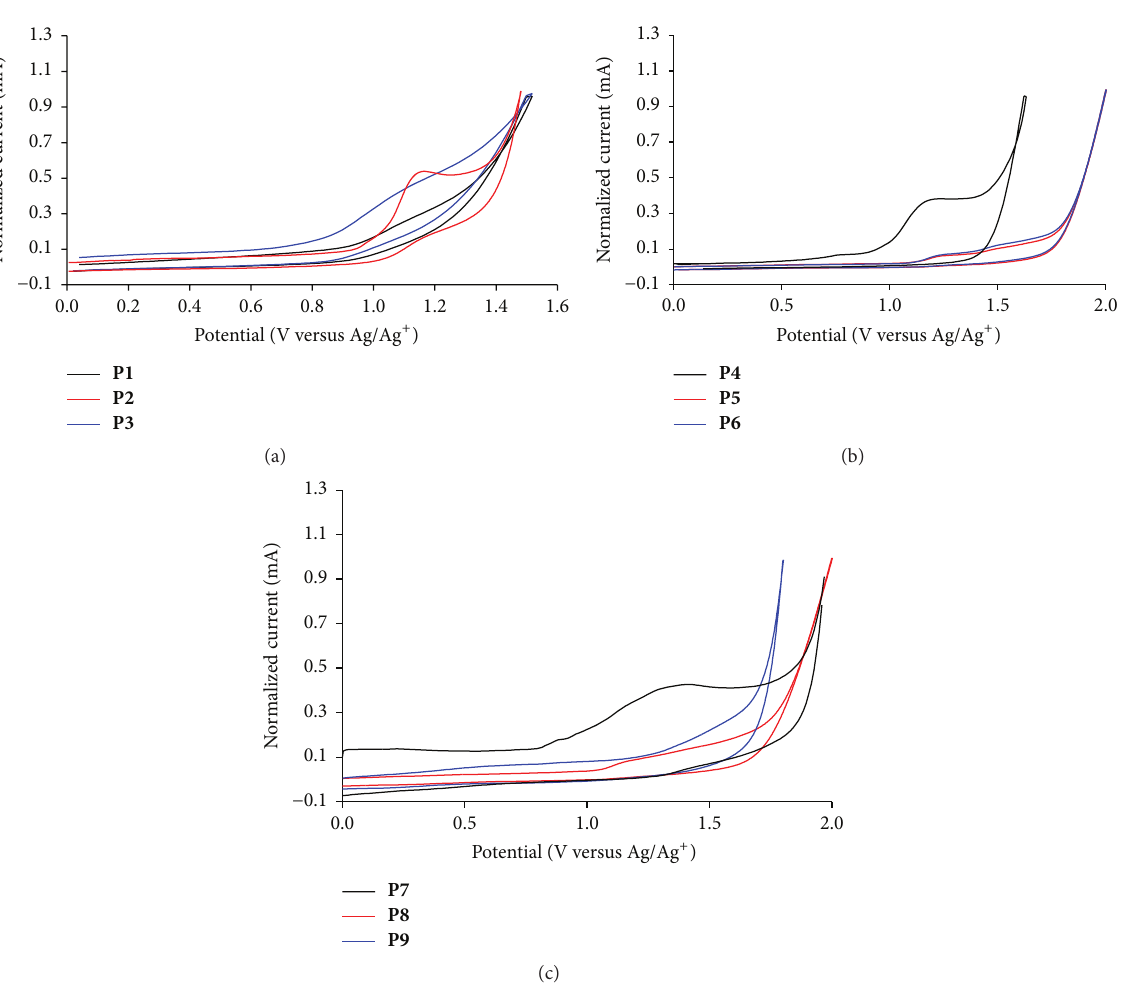
Figure 6: Cyclic voltammogram (0.1Vs −1 ) for (a) compounds P1 , P2 , and P3 ; (b) compounds P4 , P5 , and P6 ; and (c) compounds P7 , P8 , and P9 with ferrocene as an external standard in DMF—0.05 M n Bu 4 NPF 6